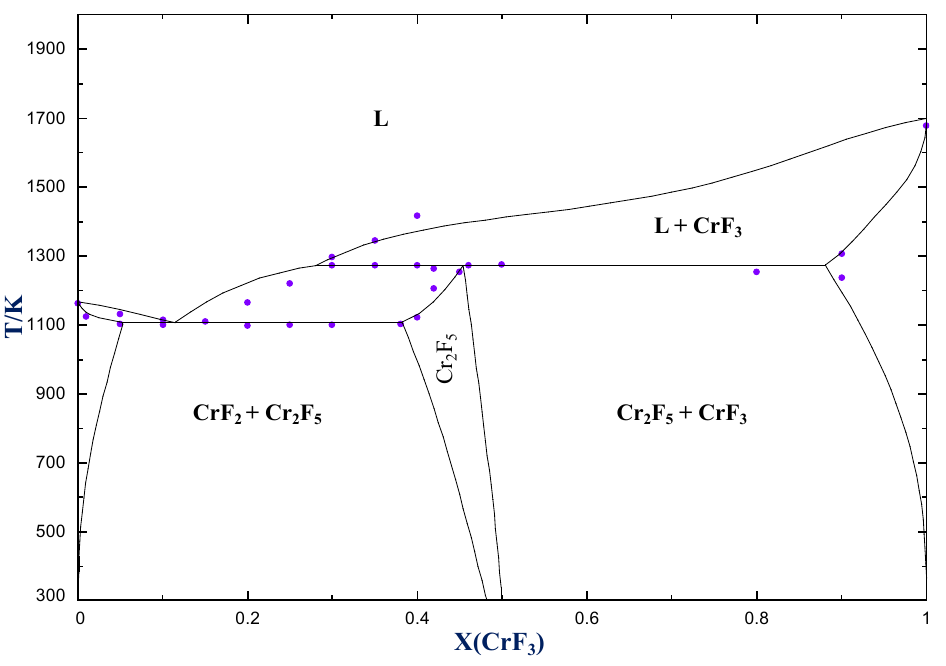
Figure 1. Phase diagram of the CrF 2 –CrF 3 system optimized in this work compared with the experimental data provided by Sturm